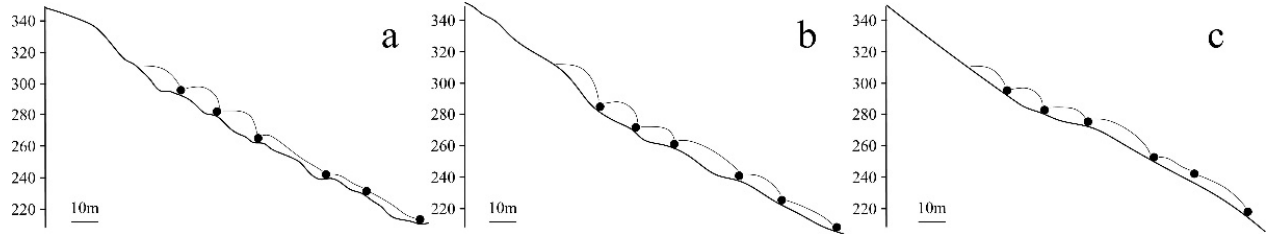
Figure 12. Theoretical 2D profiles of a rockfall event, drawn on a topographic profile extracted from the 1 m resolution DEM ( a ), the 5 m resolution DEM ( b ) and the 30 m resolution DEM ( c ).